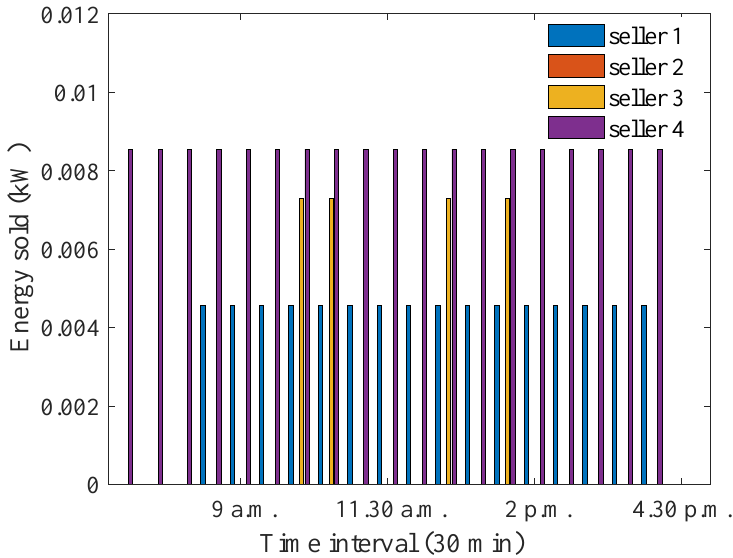
Figure 25. Optimum energy sold for equally preferred sellers and buyers when distance between house 4 and the aggregator is decreased.